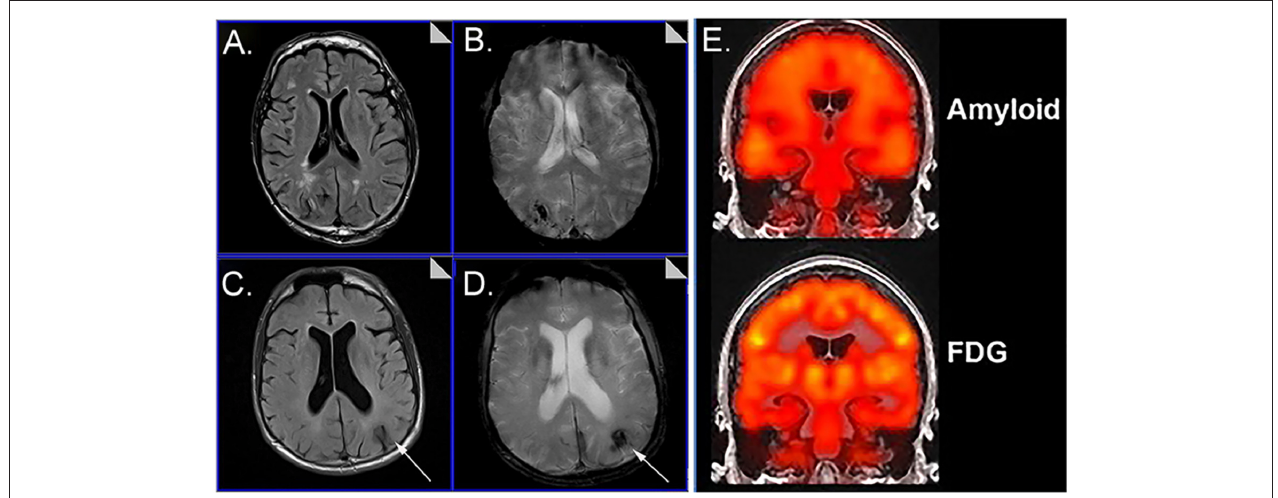
FIGURE 1 | Representative examples of neuroimaging protocols acquired in Down syndrome. Panels (A–D) show MR imaging in a 57 year old male and 59 year old male imaged with T2* (A, C) and FLAIR (B, D) showing the presence of microbleeds. Arrows distinguish edema and hemosiderin positive microbleeds. Panel (E) shows examples of amyloid PiB-PET imaging (top) and FDG-PET imaging (bottom). Images from (A–D) were modified from Figure 5 with permission of Elsevier Press (Head et al., 2018). Images from (E) were modified from Figure 1 reproduced with permission from Dr. M. Rafii and under the Creative Commons Attribution License (CC BY) ( Rafii et al.,